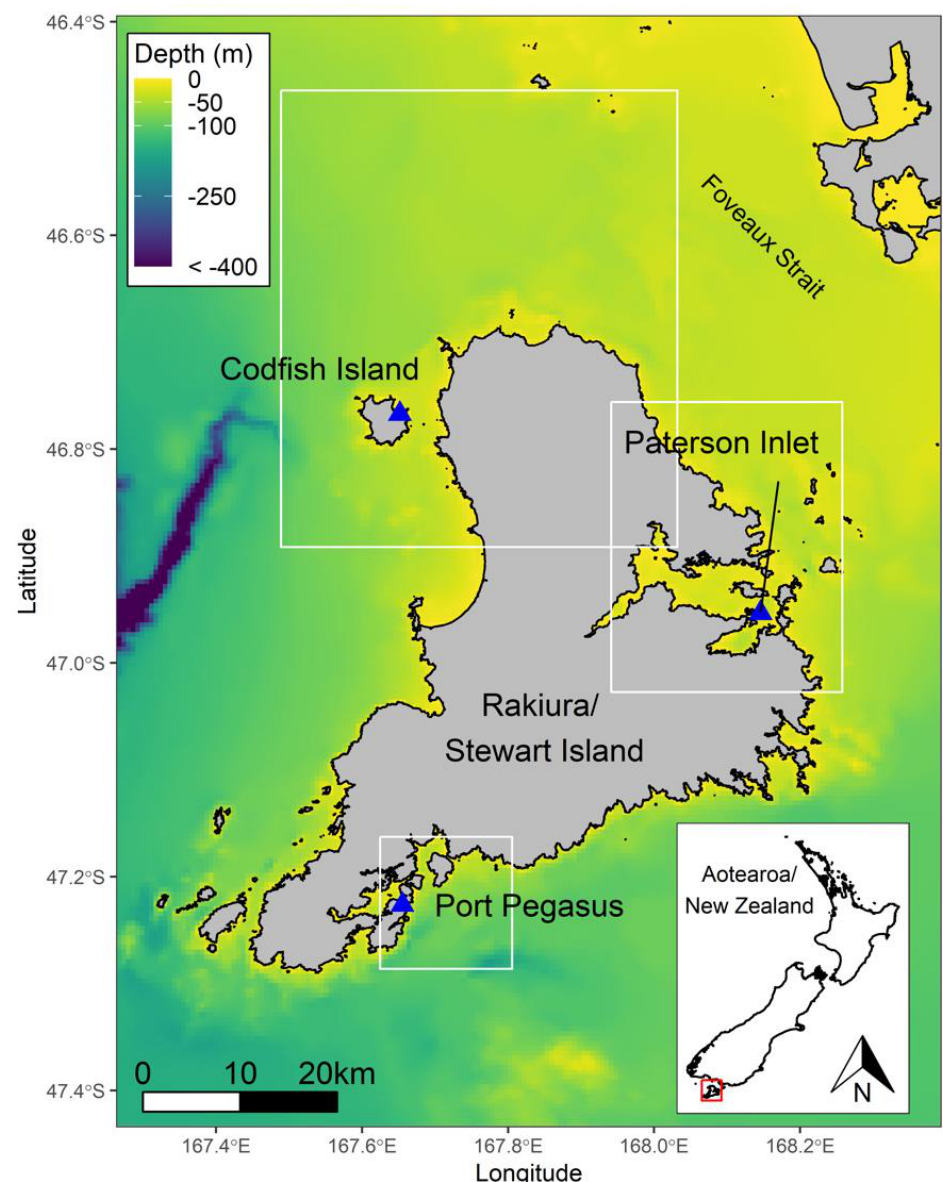
Figure 1. Stewart Island showing the three study sites, Port Pegasus, Paterson Inlet, and Codfish Island. For device deployments and retrievals, all penguins were captured on the nest or on access tracks in transit to or from nesting areas and restrained inside a cloth bag. Adult birds were weighed using 10 kg Pesola spring balance scales (100 g–10 kg), and head and Table 1. Mean ± 1 SD parameters of breeding yellow-eyed penguins at Port Pegasus ( n = 7), Paterson foot measurements were taken with an osteometric board to determine sex [57]. GPS-TDR Inlet ( n = 6), and Codfish Island ( n = 6) during the 2020/21 season. loggers were attached to the penguins’ lower back using waterproof adhesive tape (Tesa ® tape, No. 4651; Beiersdorf AG, Hamburg, Germany) secured on top with Pattex Kraftkleber glue (Henkel AG, Düsseldorf, Germany) following the methods detailed by Wilson & Wilson [58] and Wilson et al. [59]. In addition to these methodologies, a plastic cable tie was secured around the device and tape to further secure the anterior portion of the device to the lower back [60]. After recapture, device retrieval took c. 5